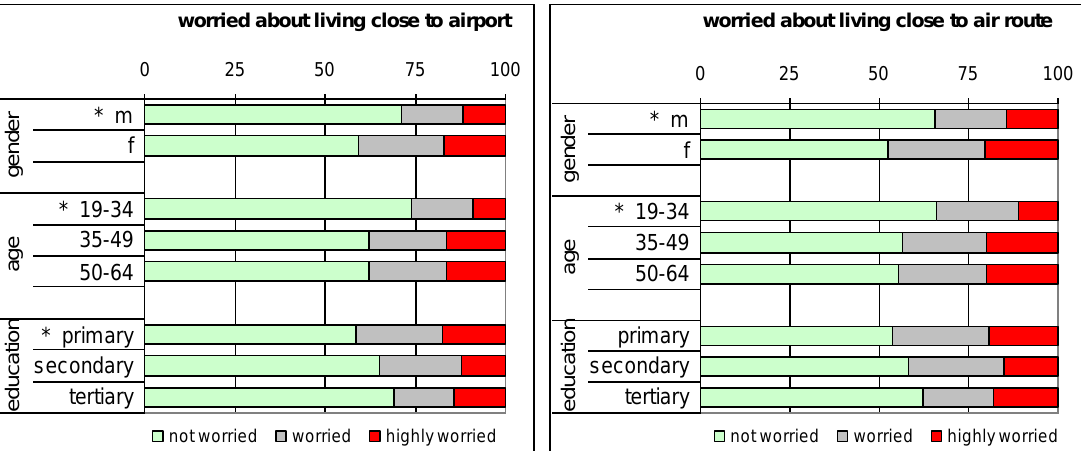
Figure 2. Percentages of respondents that are not, somewhat or highly worried about living close to airport (left panel) or close to an air route (right panel), stratified by gender, age group and education level. * indicates significant difference ( p < 0.05).